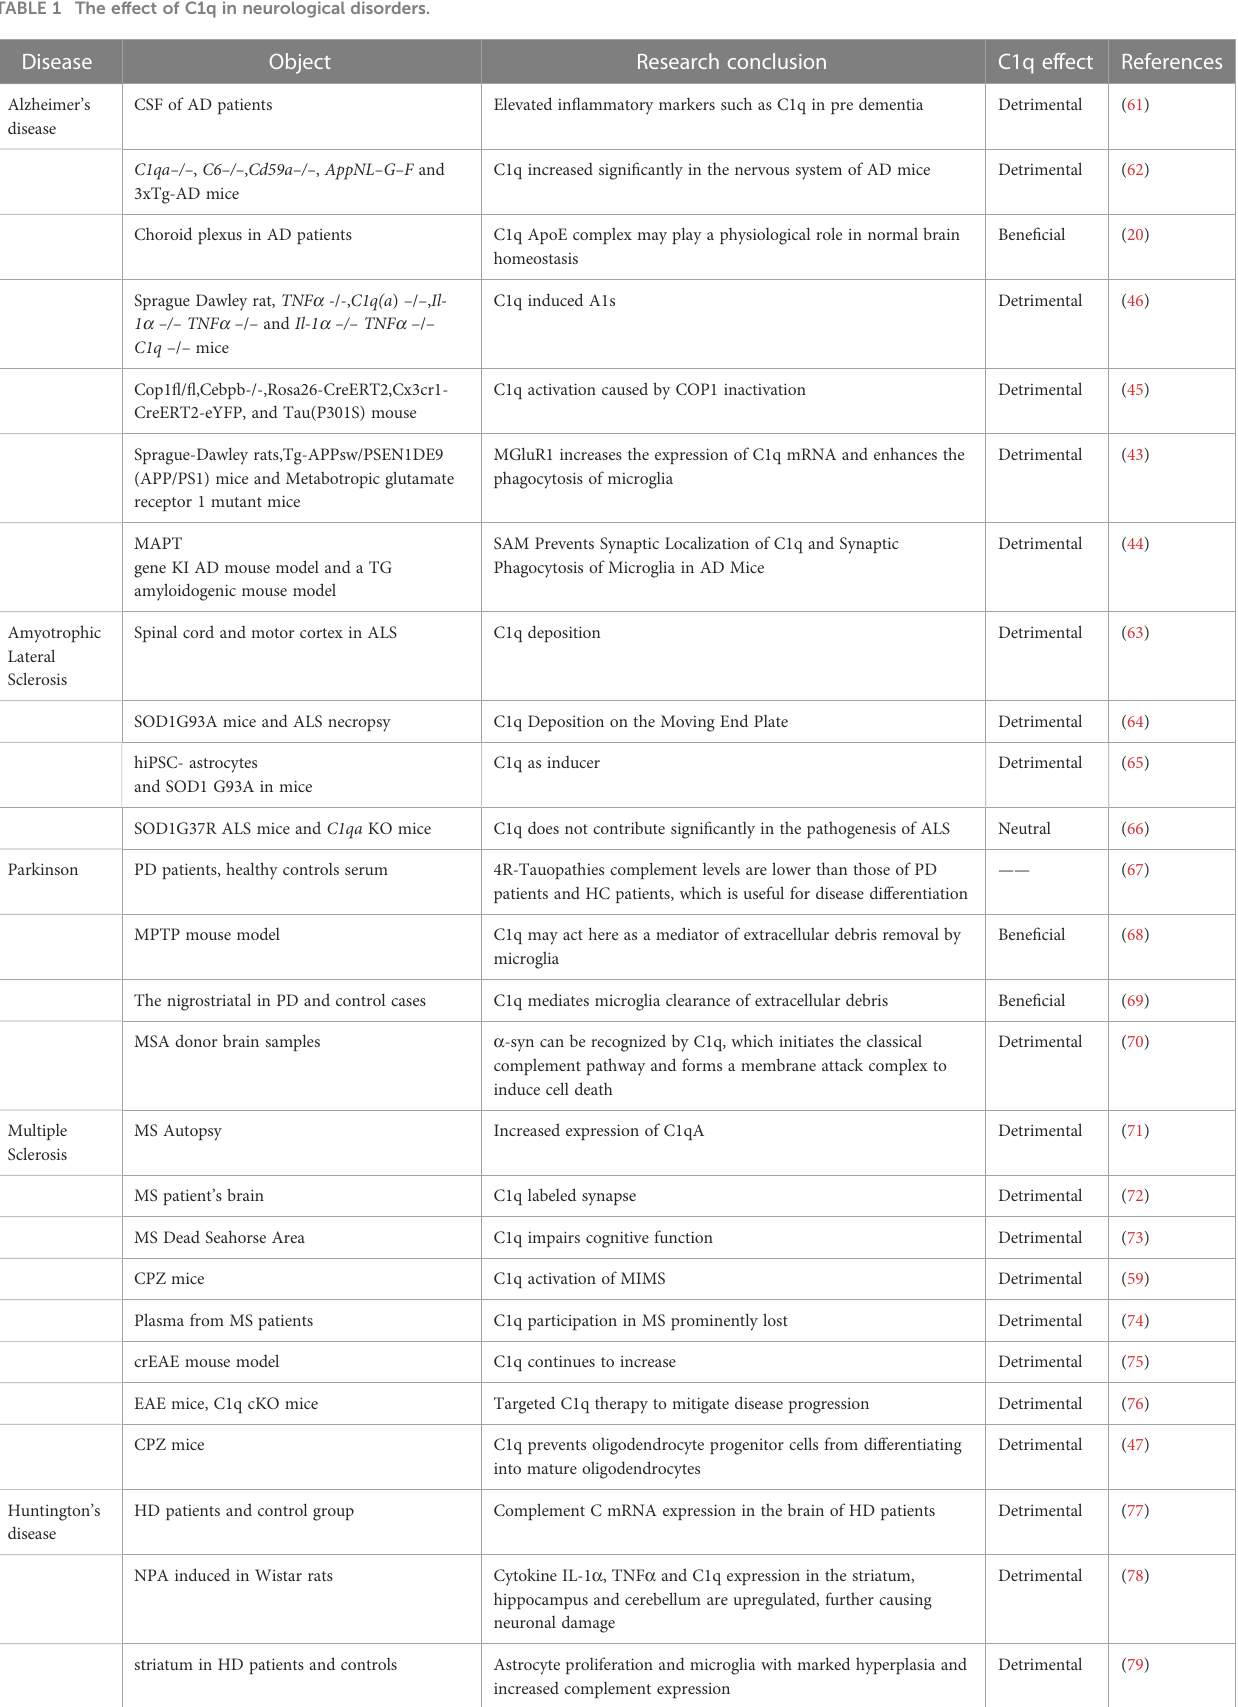
TABLE 1 The effect of C1q in neurological disorders.